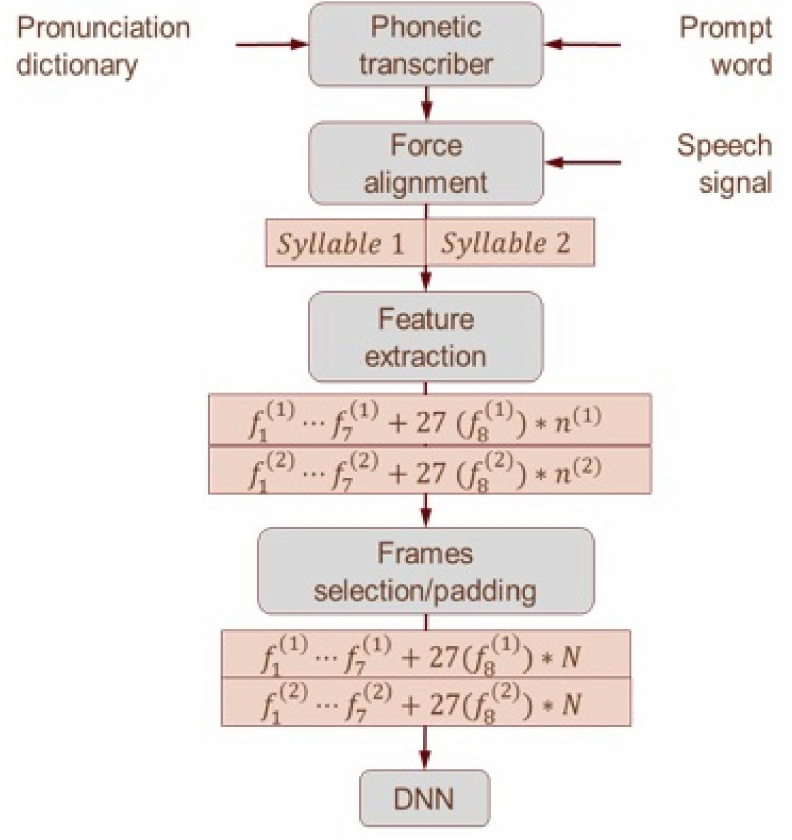
Figure 1. Flowchart depicting the automated classification process. f i (1) and f i (2) are the i th feature of the first and second syllable, respectively; nˆ((1)) and nˆ((2)) are the number of frames of the first and second syllables’ nuclei, respectively; and N is the number of input frames. Table 2. The extracted acoustic